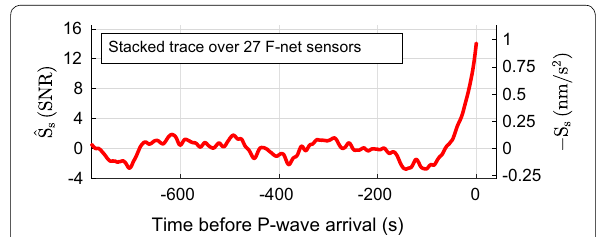
Fig. 4 Consistency between observed PEGS amplitudes and V17 modeling. Stacked trace (station‑averaged vertical acceleration) of the same 27 sensors considered in Fig. 7a of K19, but deconvolving the data by the instrument response (as done in V17) before stacking. Note that the stacked trace S s is shown with an opposite sign (scale to the right). The stack SNR (scale to the left) is defined as the ratio between |S s | and the standard deviation of noise calculated in the 10 min preceding earthquake origin time. At the P wave arrival, S s ~ 1 nm/s 2 and SNR ~ −